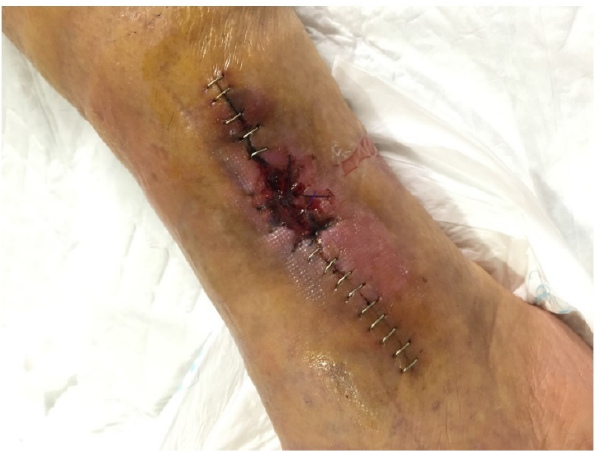
Figure 4. Skin necrosis and wound dehiscence probably due to excessive